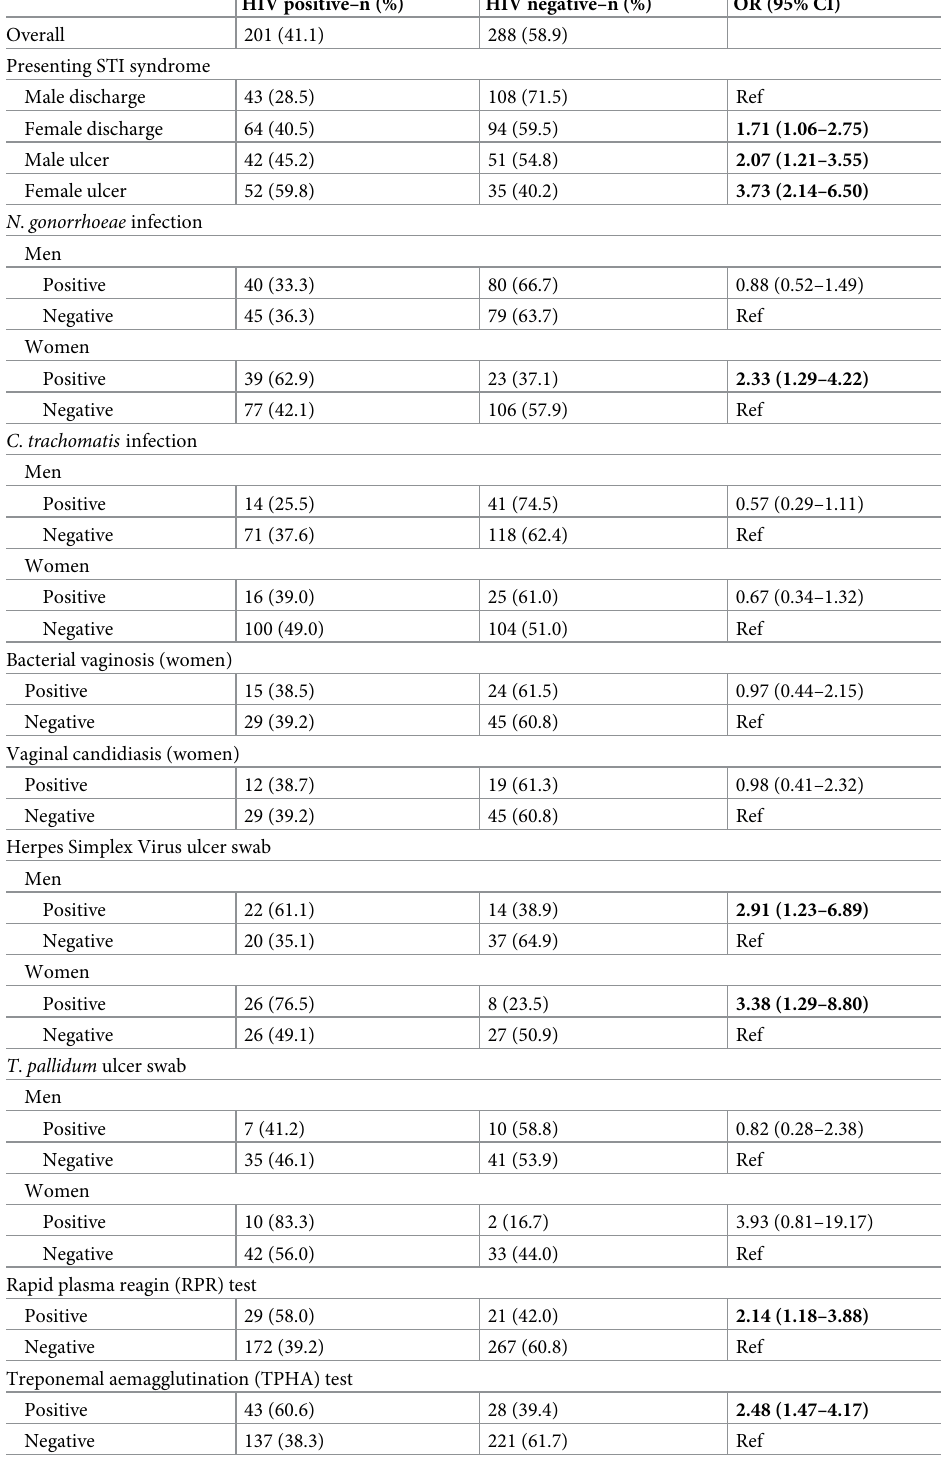
Table 2. Sexually transmitted infection (STI) associations with prevalence of HIV-1 infection in STI clinic patients, Zimbabwe–